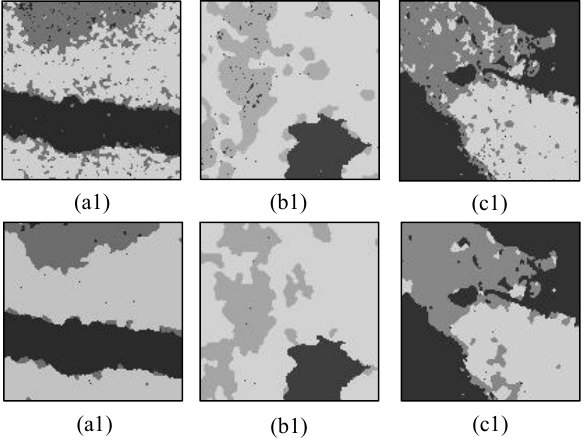
Figure 6. Segmentation results with comparing algorithms for real SAR